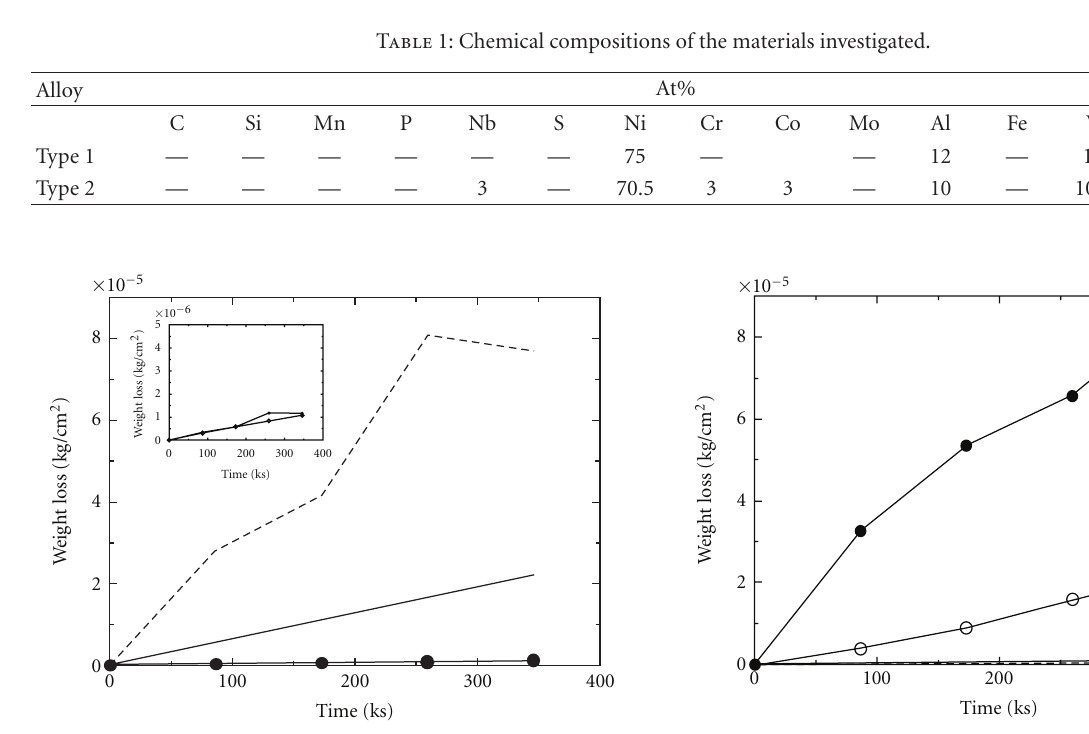
Figure 4: The weight losses of Ni 3 Al/Ni 3 V two-phase intermetallic compounds: • type 1, (cid:2) type 2, (solid line) Ni 3 (Si,Ti), and (dotted line) Type 304 as a function of immersion time in 0.5kmol/m 3 HNO 3 solution at